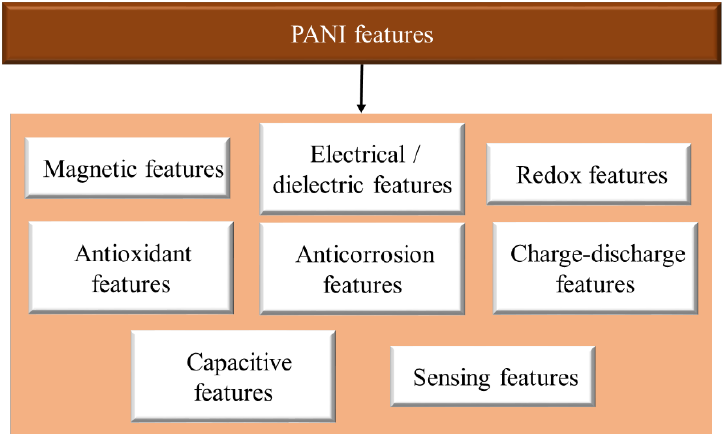
Figure 20. Features of